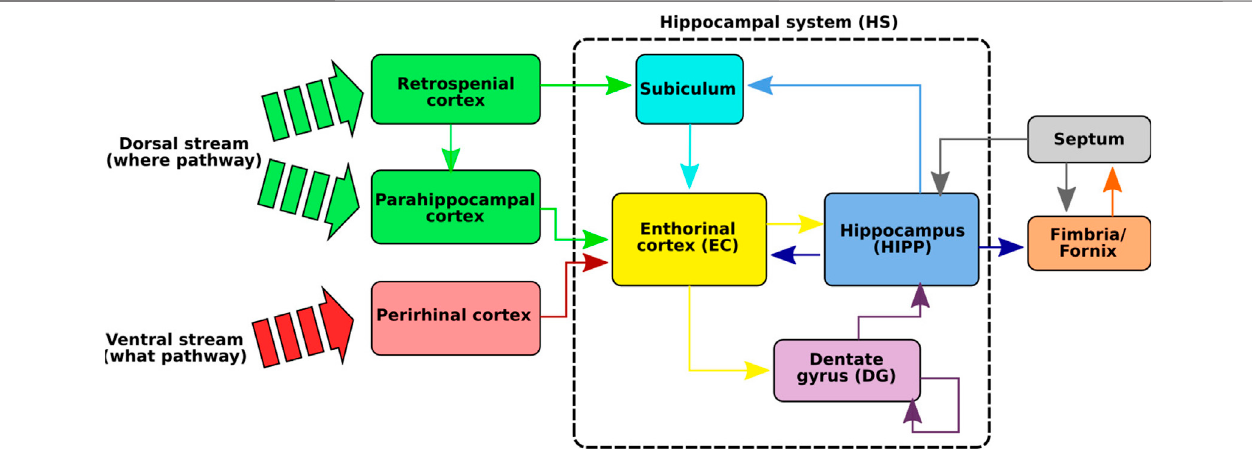
FIGURE 2 | Illustrationofthehippocampalsystem(HS).Thefunctionalpathofspatialmemorybeginsintheperirhinalandparahippocampalcorticesthat fi lterandencode the idiothetic and allothetic information from the neocortices. These two pathways are merged in the entorhinal cortex before reaching the hippocampus, either directly or via the dentategyrus.Severalneurons,sensitivetospatialinformation,havebeenidenti fi edintheHS: placecells sensitivetoparticularpositions, spatialviewcells respondingtopointsof view, and head direction cells tuned to speci fi c head directions. A particular loop has also been identi fi ed between the hippocampus and the septum (septo-hippocampal loop) and seems to play an important role in the learning of new events in the HS via cholinergic modulations in the HS (Hasselmo, 2006).